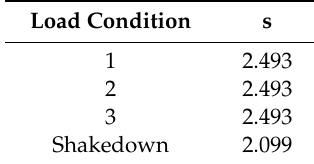
Table 4. Calculated load multipliers limits.